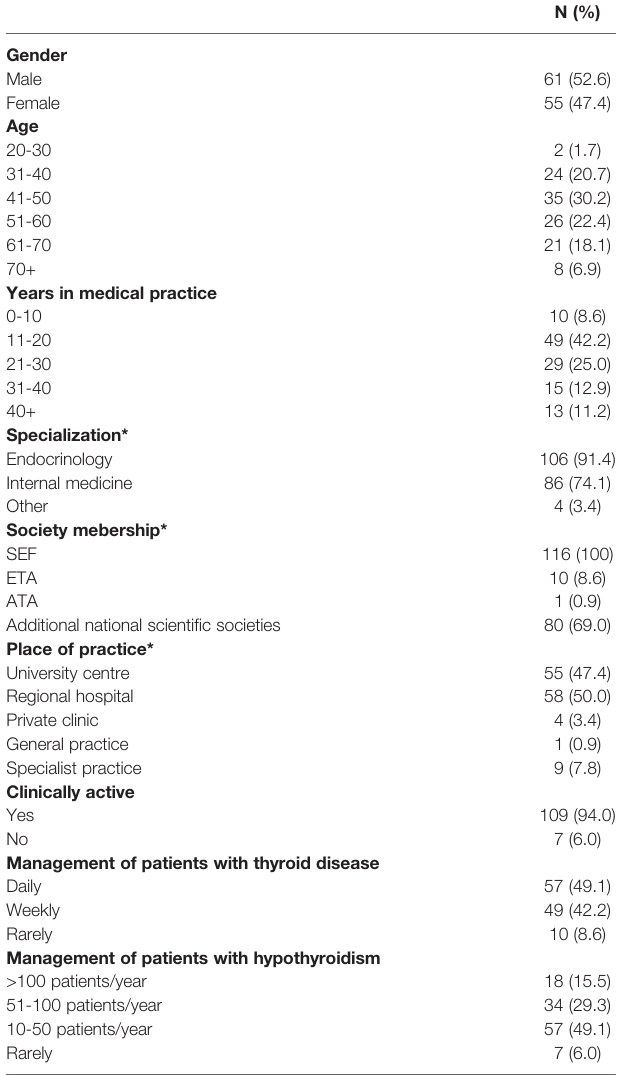
TABLE 1 | Characteristics of the 116